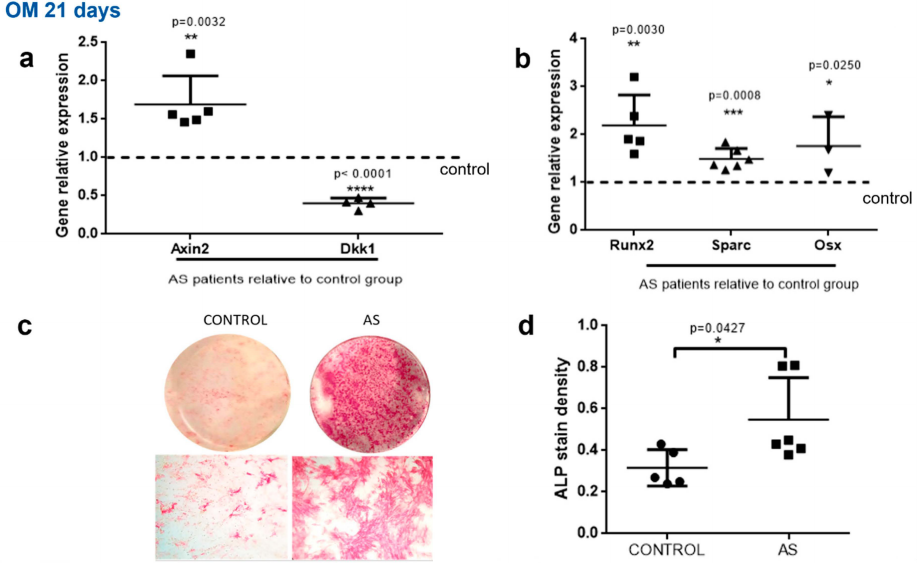
Figure 2. Decreased DKK1 expression and enhanced WNT pathway signaling and osteoblast dif- ferentiation in AS. MSCs from the control group and the AS group were cultured in vitro with osteogenic medium (OM) for 21 days. ( a , b ) Axin2, Dkk1, Runx2, Sparc and Osx expression levels were determined with the quantitative RT-PCR method. Each gene’s expression is presented as a fold expression in AS cells relative to the control group expression normalized to unity. ( c , d ) ALP activity in cultured cells. ( c ) Whole culture dish images (top row) and microscopic photographs (bottom row). ( d ) Scatter plots depicting the quantification of ALP stain density. Data are presented as mean ± SD. * = p < 0.05; ** = p < 0.01; *** = p < 0.001; **** = p <